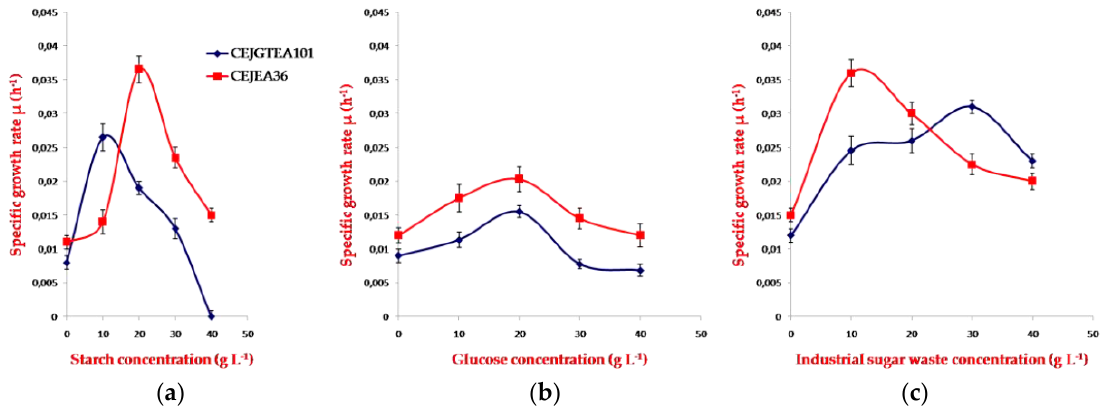
Figure 3. ( a ) Starch, ( b ) glucose, and ( c ) sugar waste concentration ranges for growth on PHA- accumulating medium of strains CEJGTEA101 and CEJEA36 under optimized conditions. Data are shown as means of duplicate with their standard errors. µ : specific growth